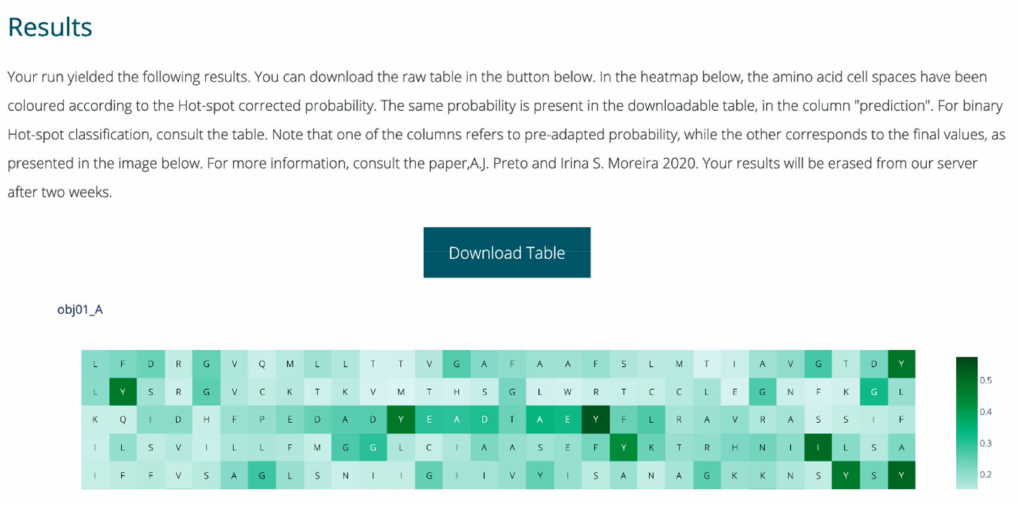
Figure 3. Sample of the output page of